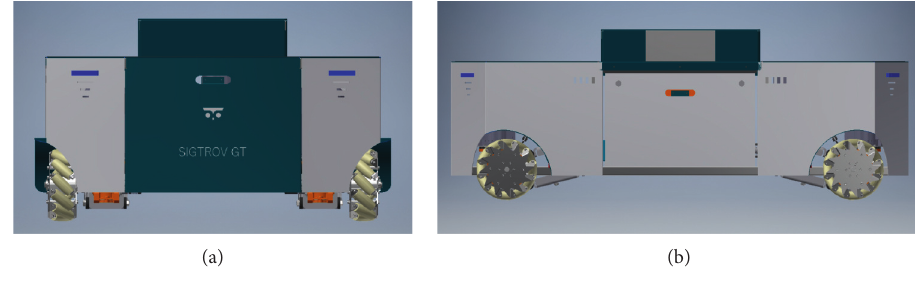
Figure 5: (a) Front and (b) lateral view of the AGV.